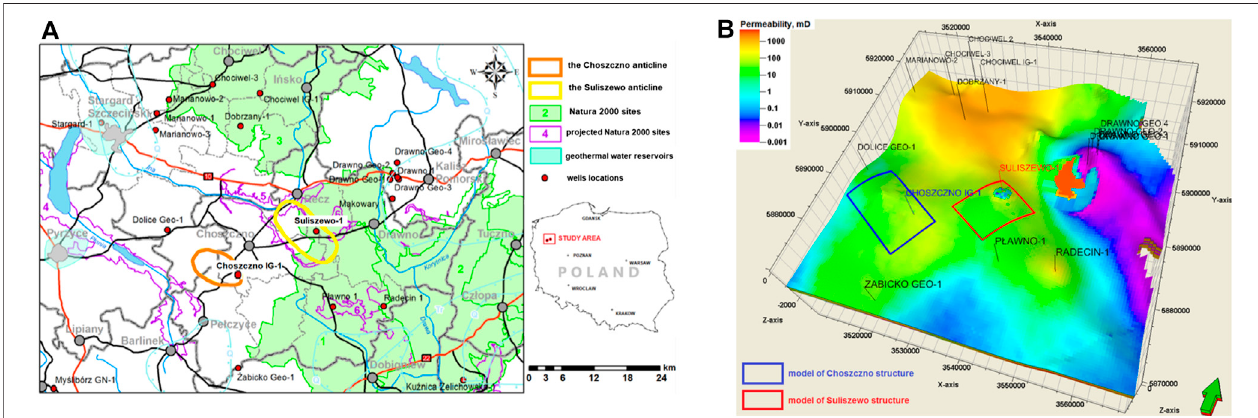
FIGURE 1 | Choszczno-Suliszewo area: (A) Location map and (B) structures delineated in a static numerical model.